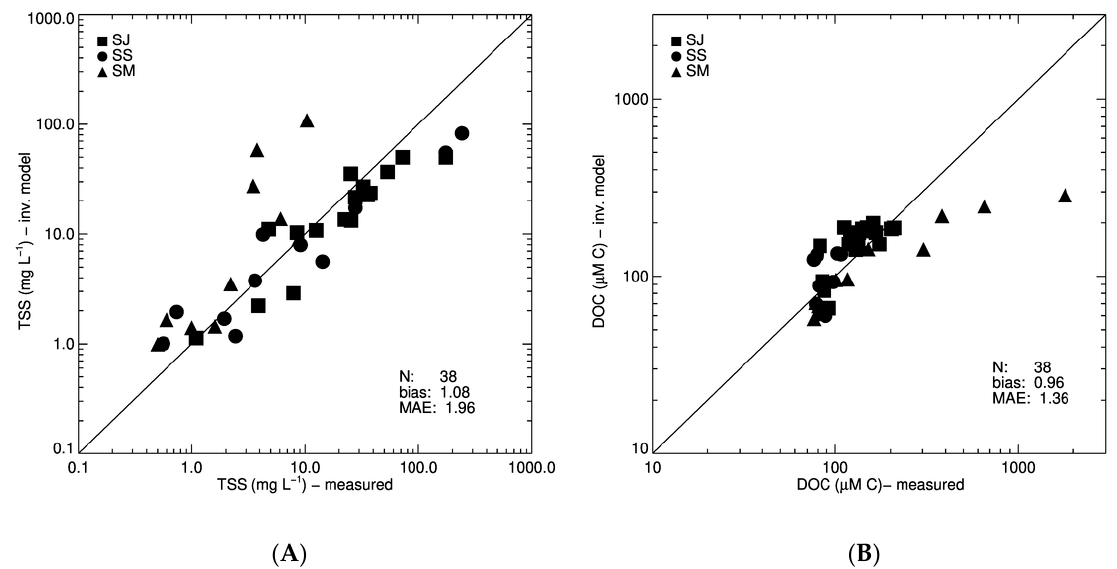
Figure 8. Predictive error estimates of optical inversion model using the leave-one-out cross validation method. ( A ) TSS retrieval comparisons and ( B ) DOC retrieval comparisons with uT measurements as an input to the inversion model.